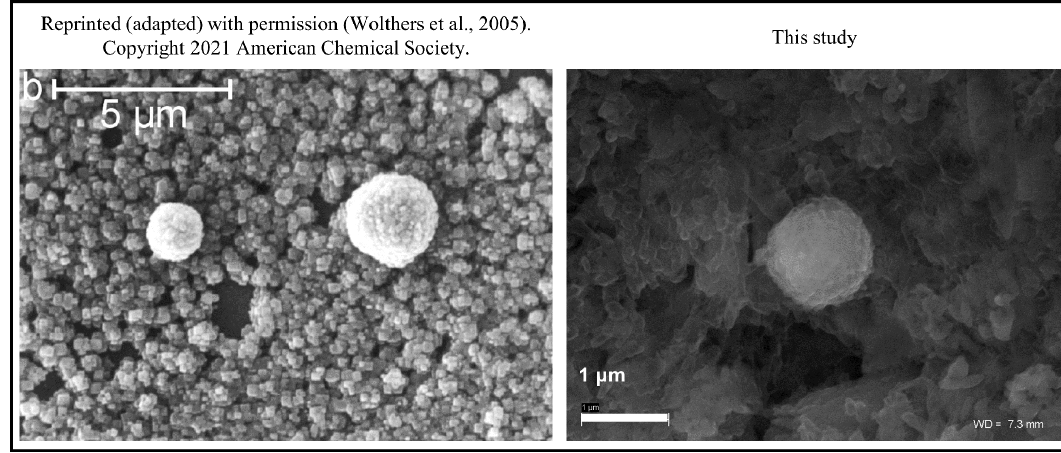
Figure 9. The framboidal structures obtained by Wolthers et al. (2005) and obtained during our experiments. Note nearly identical shapes in both cases but under different experimental conditions.